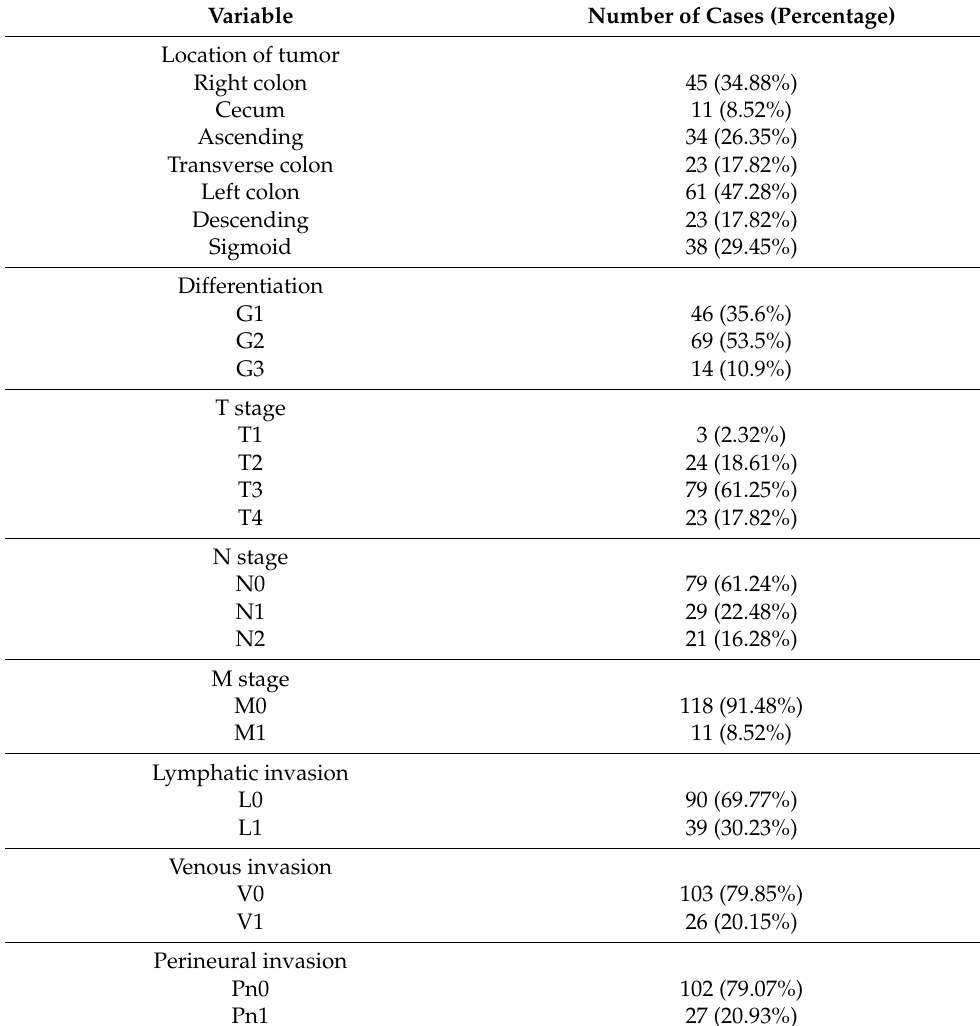
Table 2. Tumor-specific pathological characteristics of the